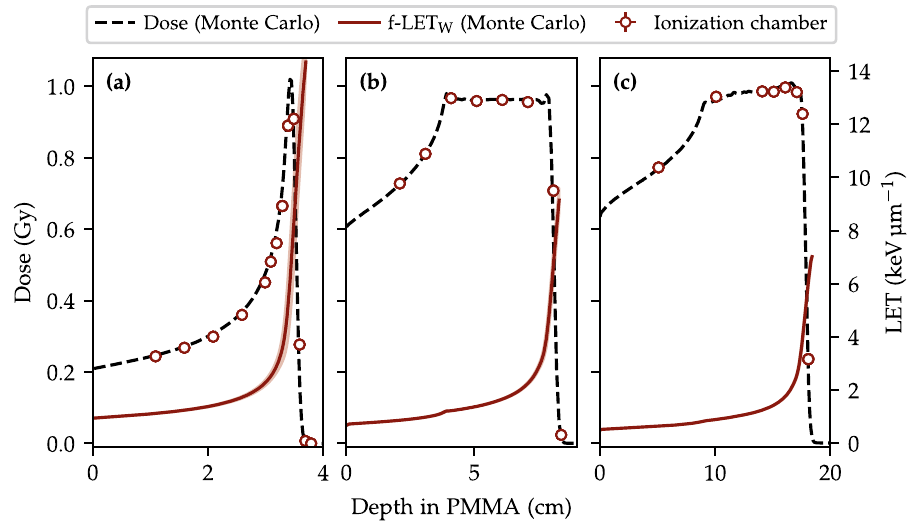
Figure 1. The three fields in Table 1 where the single energy layer f 1 is shown in ( a ), the SOBP f 2 in ( b ) and SOBP f 3 in ( c ). Open markers denote measurements with an ionization chamber placed next to the OSLDs during the irradiations. The simulated f- LET W depth profiles are shown with solid lines along with a band showing the LET given a 0.5 mm misalignment for